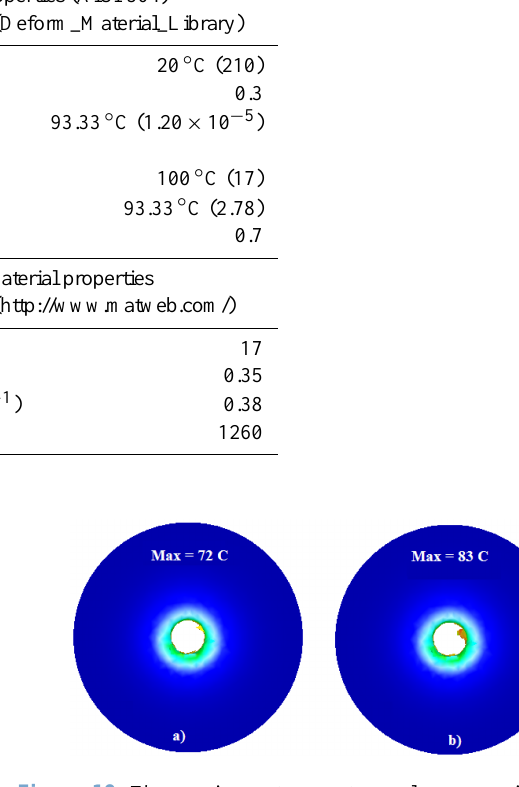
Figure 10. The maximum temperature values occurring in bone model at the different spindle speeds: (a) 400rpm and (b)